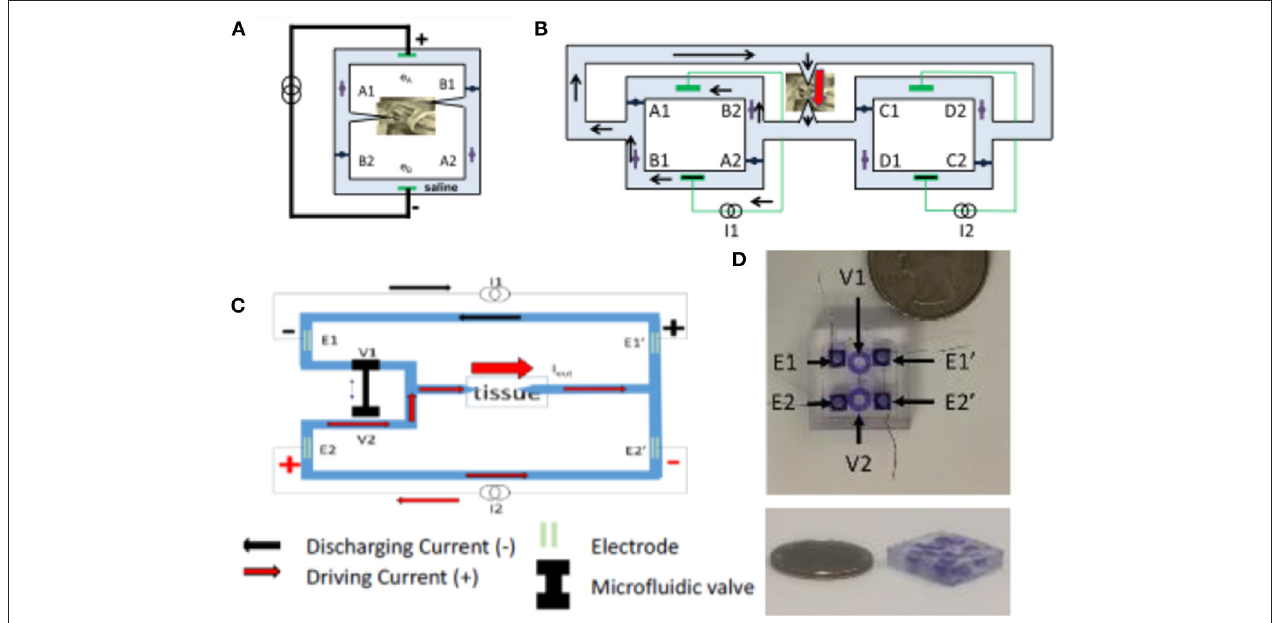
FIGURE 2 | (A) SDCS 1. (B) SDCS2 was designed to remove interruptions in current flow observed in SDCS1 construction. (C) SDCS3 is designed to remove the current flow interruptions, reduce power consumption and improve reliability. (D) SDCS3 microfluidic implementation. Figures adapted with permission from Fridman and Della Santina (2013a) and Fridman